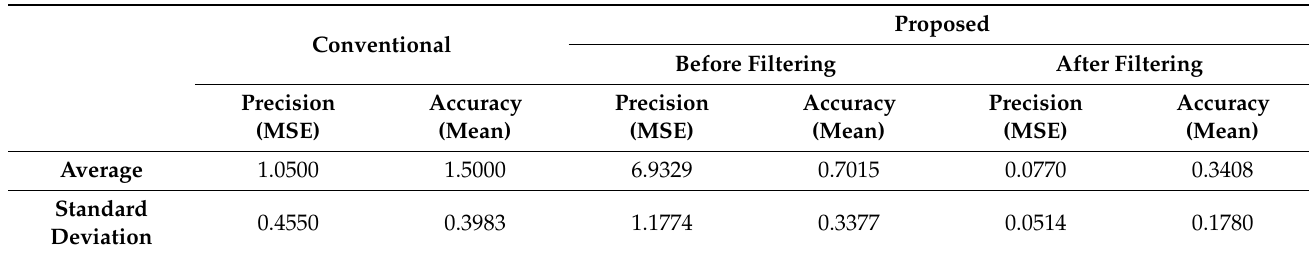
A comparison between the precision and accuracy obtained from the conventional approach and the proposed approach.